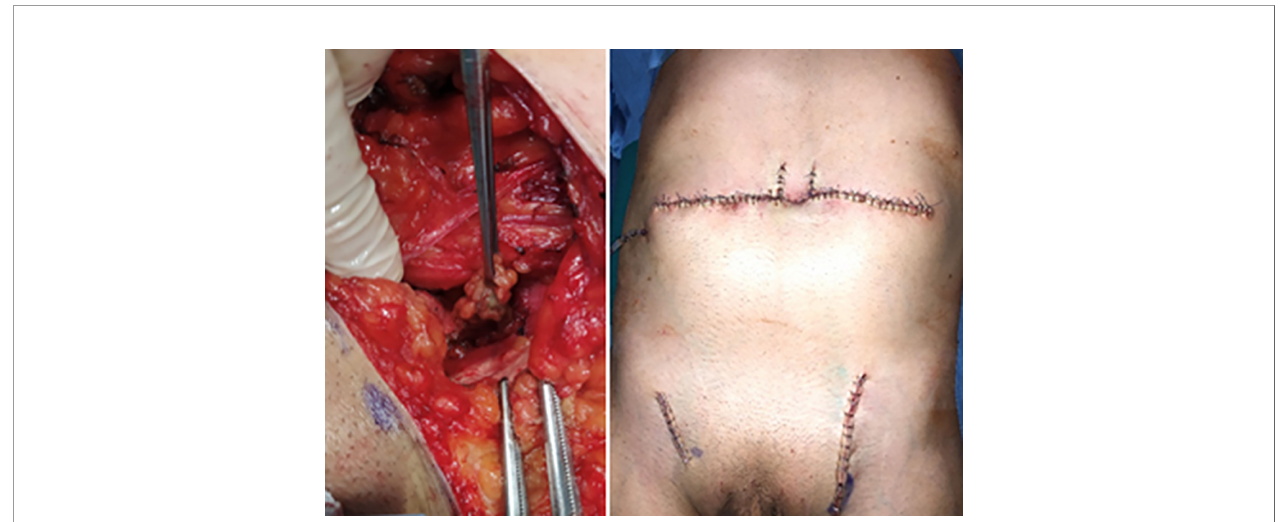
FIGURE 2 | Operative views: Sentinel node in the left external iliac area and postoperative